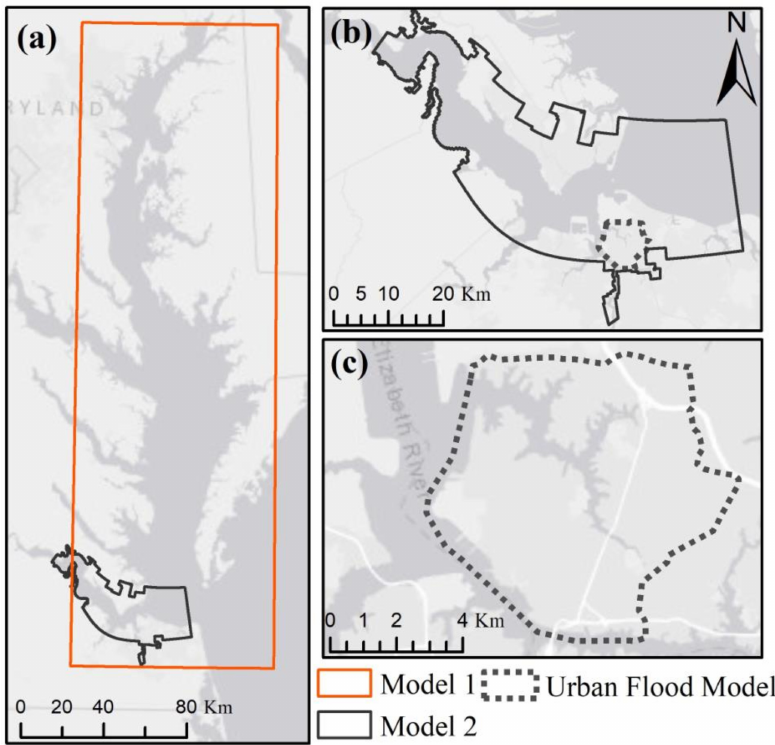
Figure 1. Storm surge model and urban flood model domains: ( a ) Model 1, ( b ) Model 2, and ( c ) urban flood